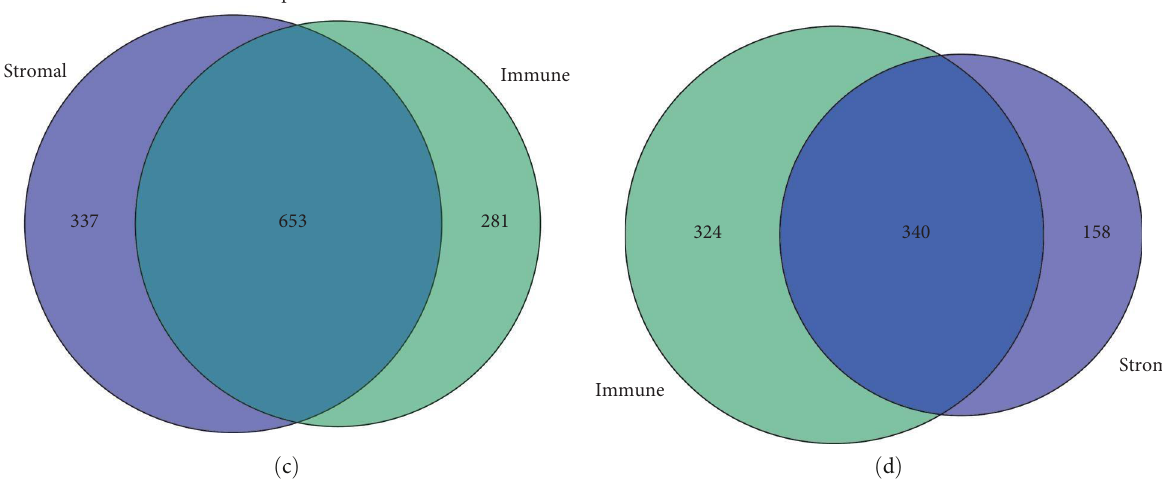
F IGURE 2: Heatmap (blue: downregulation; red: upregulation) for DEGs. (a) Heatmap generated by comparison of the high-score group vs. the low-score group in ImmuneScore. Row name of heatmap is the gene name. (b) Heatmap generated by comparison of the high-score group vs. the low-score group in StromalScore. (c) and (d) Venn plots showing common upregulated and downregulated DEGs shared by Immune- Score and